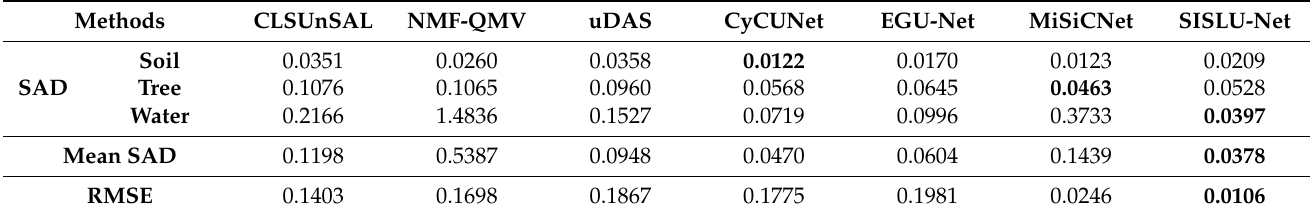
Table 8. Quantitative metrics for unmixing on the SAMSON dataset, including the SAD for each material, the mean SAD and RMSE. The optimal values are shown in bold.